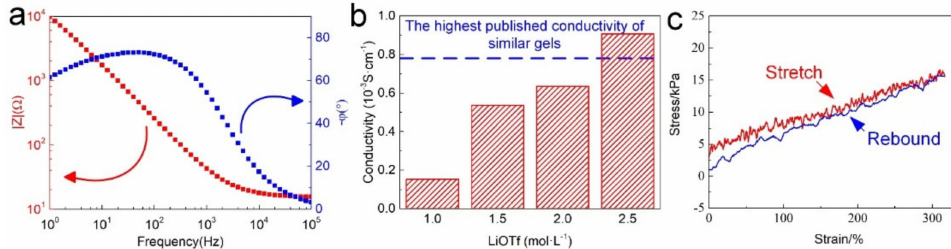
Figure 1. Schematic illustration of the proposed OICs.